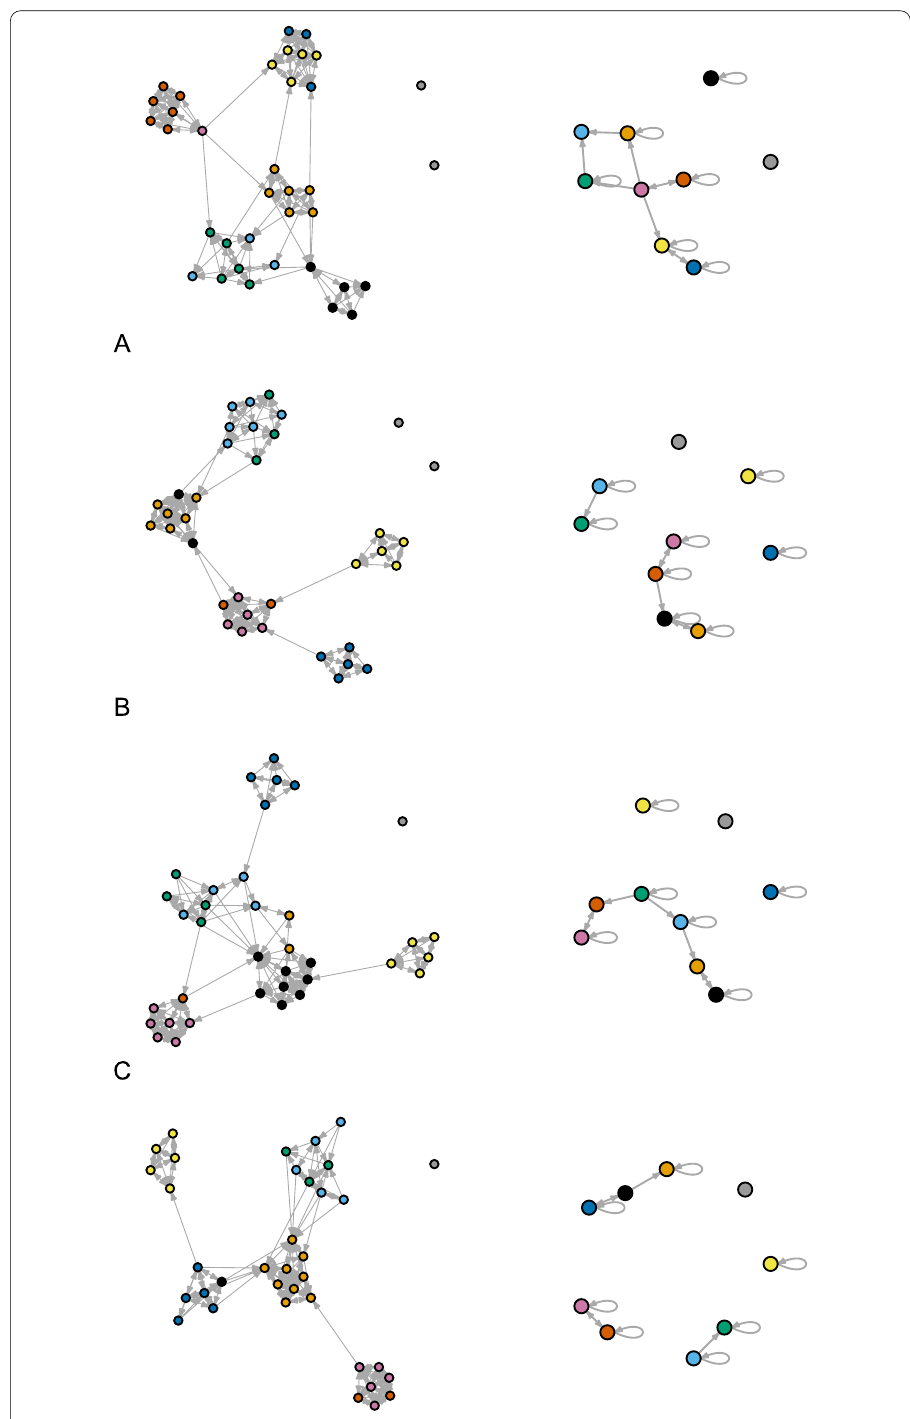
Fig. 13 Spring 2016 sociograms (left column) and reduced networks (right column) for exams